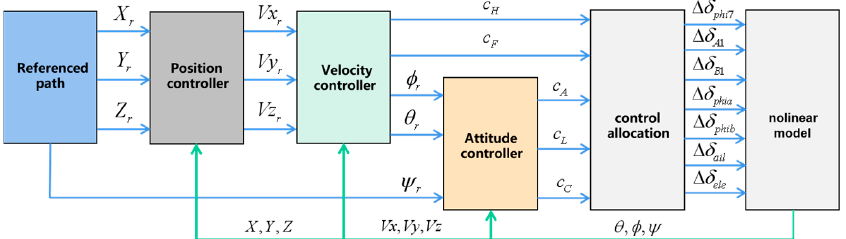
Figure 4. Trajectory tracking control structure.